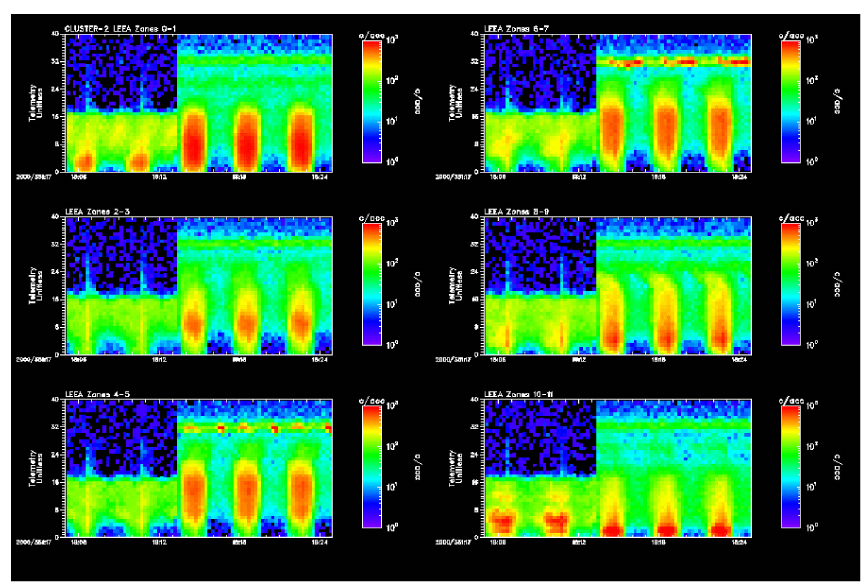
Fig. 9. Energy-time spectrograms of the PEACE/LEEA sensor over five spin periods on 16 December 2000 covering an ON-OFF transition of the ASPOC ion beam. The energy scale is quasi-logarithmic between ≈ 0 eV to ≈ 130 eV. Panels are for 6 different polar